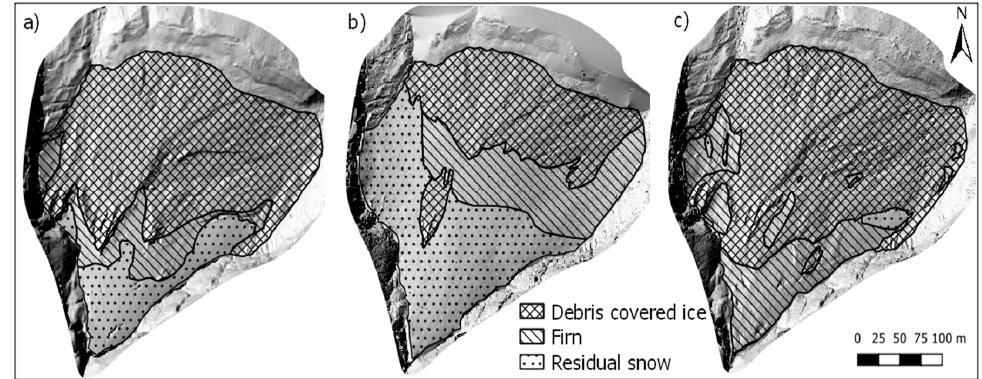
Figure 5. Spatial extent of substrata covering the Montasio Glacier at the end of the ablation season in three di ff erent years: ( a ) 2006, ( b ) 2010, and ( c ) 2019.